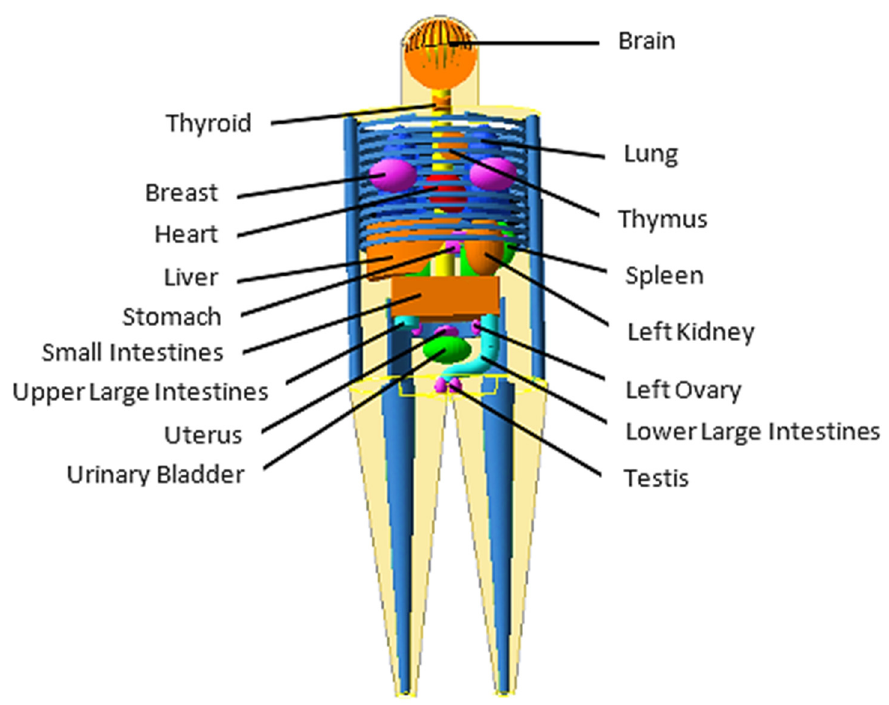
Figure 1. The MIRD-5 adult hermaphrodite human phantom as constructed and visualized using Geant4.